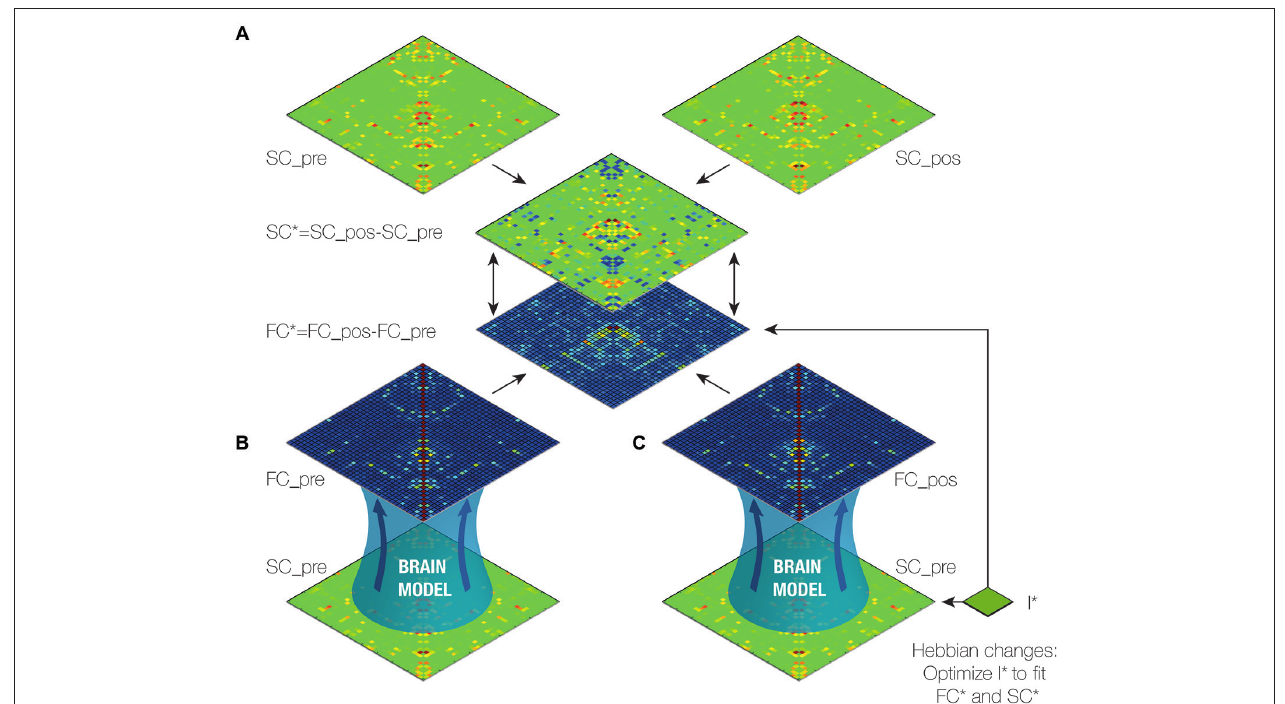
known connections from the STN. We subsequently optimized I* such that the difference between FC_pre and FC_pos (FC*) was made to fit SC*. In this way, we estimated the optimal working weights from the STN. Finally, we calculated the contribution of each of the connections from the STN to the changes in functional connectivity caused by DBS by varying the weights of each of the connections and measuring the impact on the fit (see Figure 3